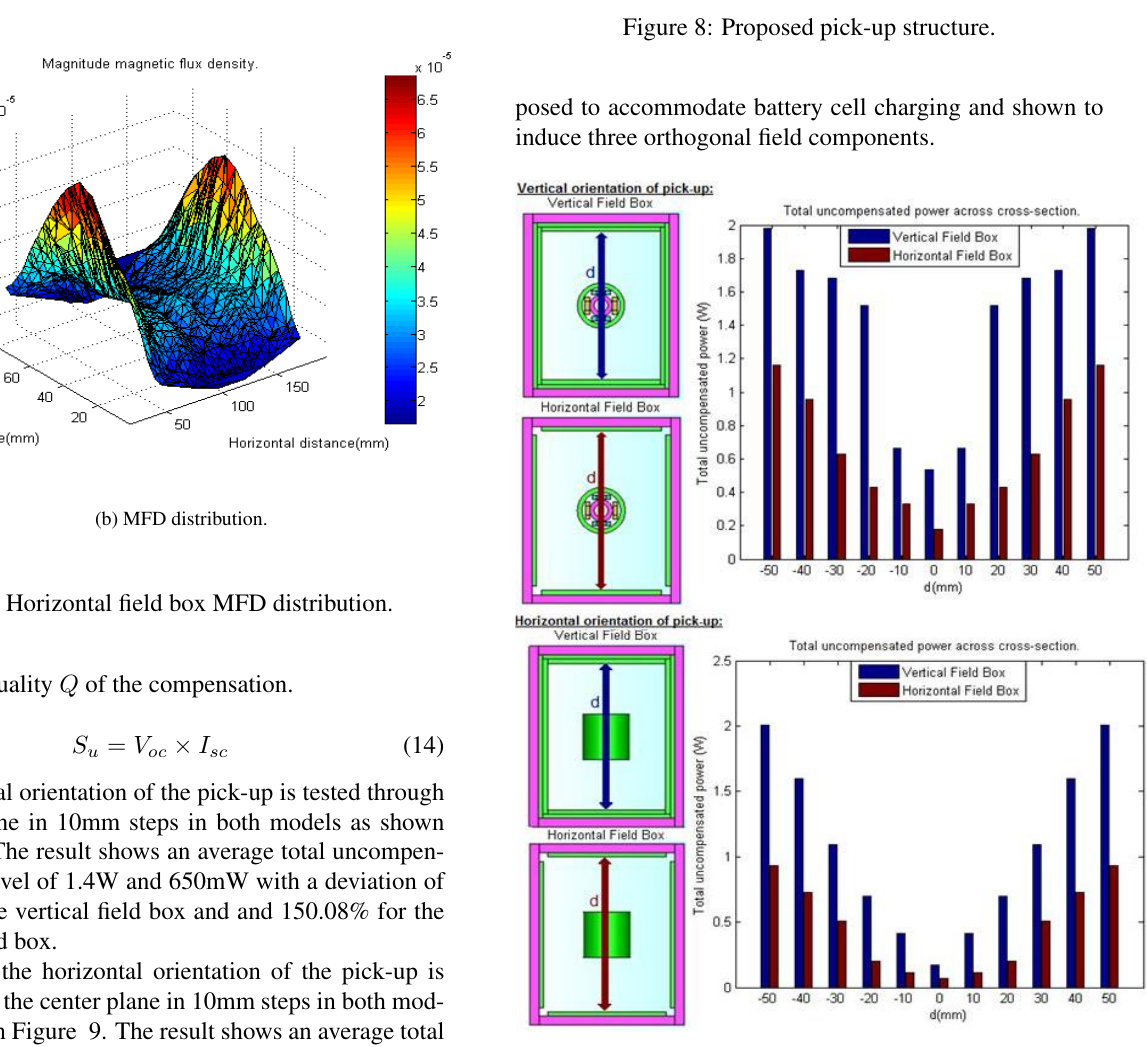
Figure 9: Pick-up